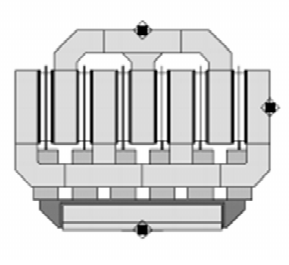
Figure 1. ED02AH 6 × 15 µ m layout.